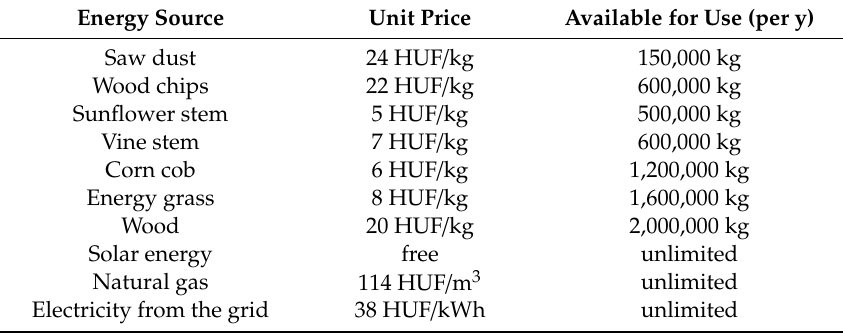
Table 4. Raw material availabilities in the case